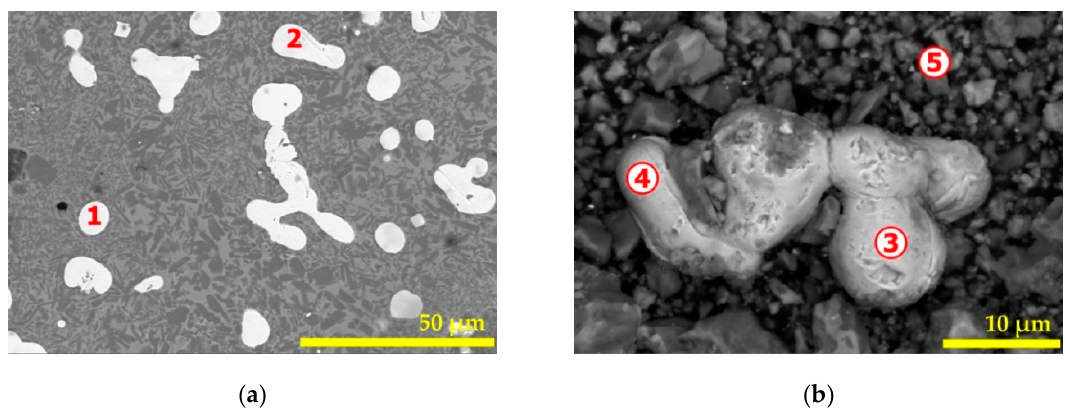
Figure 16. SEM aspects of the (hematite + W-PVC + clay) sample treated at 1025 ◦ C for 4 h: ( a ) BSE image of the polished surface sample and ( b ) BSE image of the powdered sample. Numbers 1 to 5 indicate the locations of microanalysis. Table 4. Elemental composition (EDS data) of the (hematite + W-PVC + clay) mixture treated at